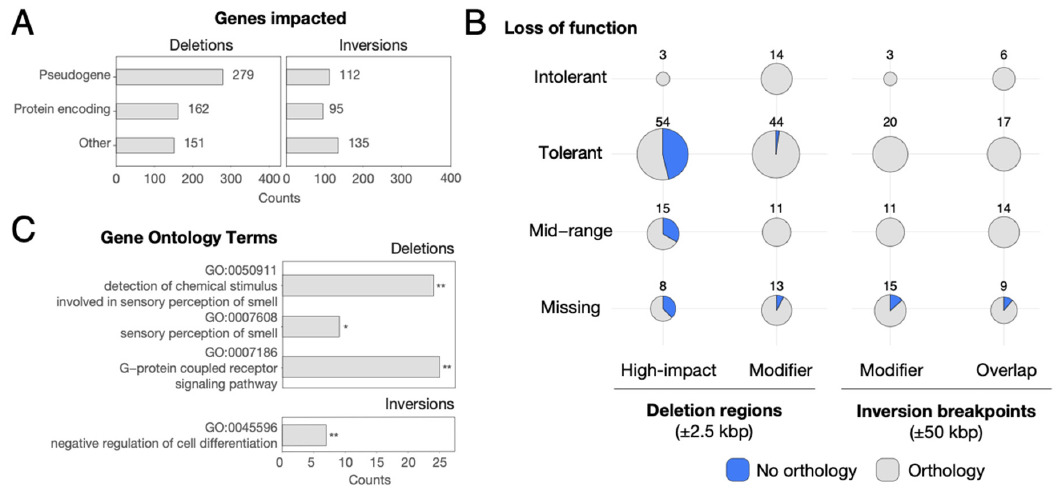
Figure 2. Description of genes overlapping identified SVs. ( A ) Categories of genes overlapping deletion regions ±2.5 kbp and inversion breakpoints ±50 kbp as defined by ENSEMBL biotypes. ( B ) Number of protein-encoding genes classified as LoF tolerant (pLI ≤ 0.1), intolerant (pLI ≥ 0.9) and middle range (pLI > 0.1 and pLI < 0.9) affected by deletions regions ±2.5 kbp and inversion breakpoints ±50 kbp. Some affected genes lack LoF information (missing category). All genes impacted by deletions were classified by VEP as either highly impacted (feature ablation or truncation) or modified, while genes impacted by inversions were either modified or no effect was predicted (overlap only). Transcribed elements with no corresponding ENSEMBL transcript ID in humans were classified as no orthology (blue). ( C ) Overrepresented GO terms in genes impacted by deletions and inversions as reported by DAVID (* q -value < 0.05; ** q -value < 0.001). Counts represent the number of genes annotated with each GO term.